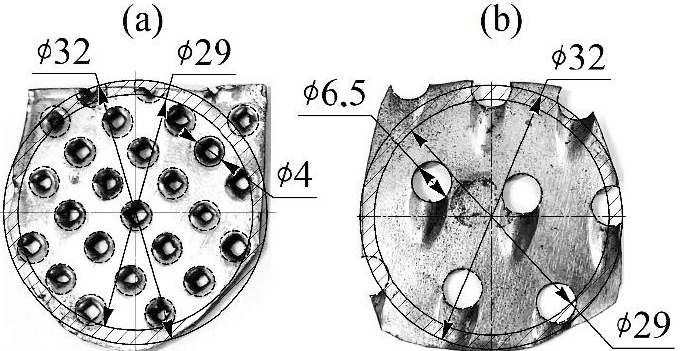
Figure 2. Photos of turbulators with main dimensions: ( а ) turbulator to create turbulence intensity TI ≈ 0.08; ( b ) turbulator for TI ≈ 0.12.